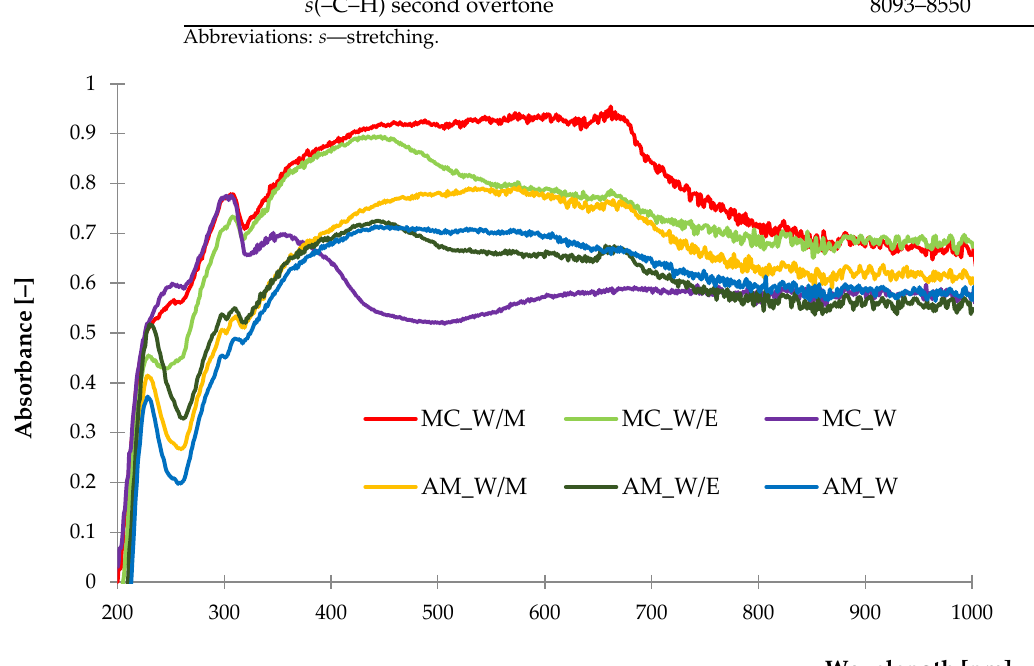
Figure 4. The UV-Vis spectra of freeze-dried extracts.